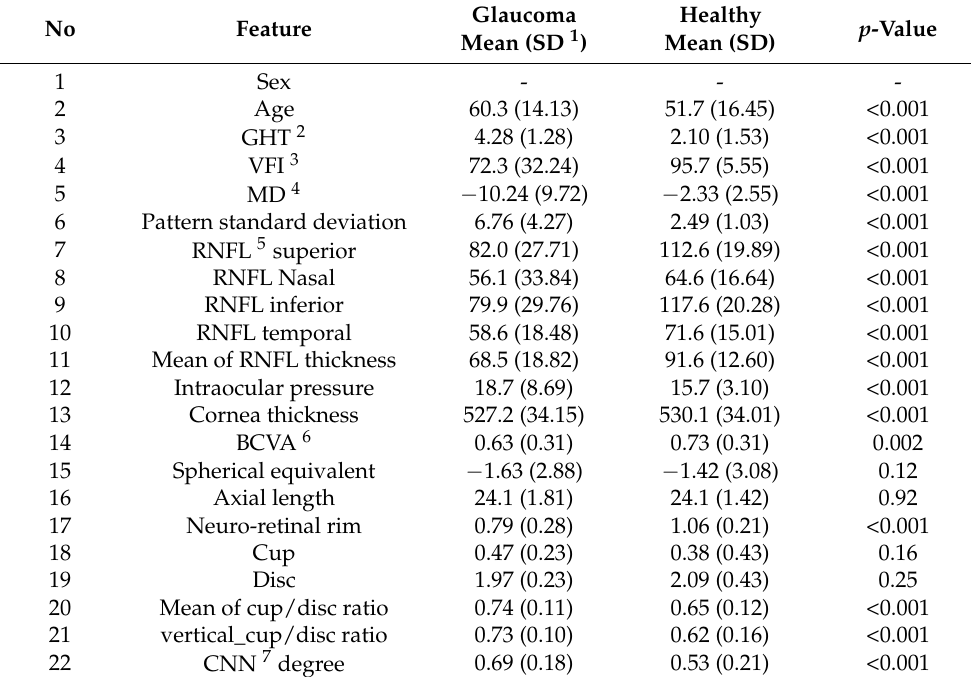
1 standard deviation; 2 glaucoma hemifield test; 3 visual field index; 4 mean deviation; 5 retinal nerve fiber layer; 6 best-corrected visual acuity; 7 convolutional neural network.